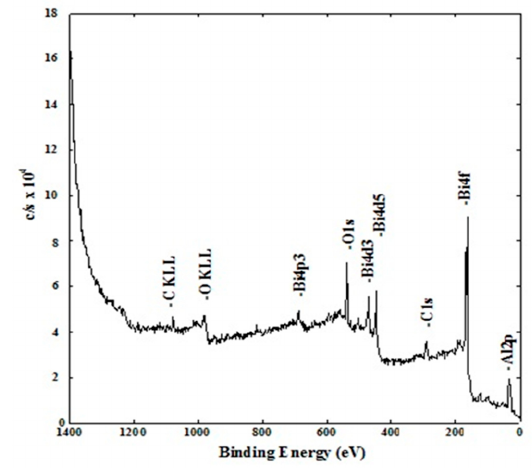
Figure 3. XPS spectrum for the compound Bi 2 O 2 CO 3 :Al .